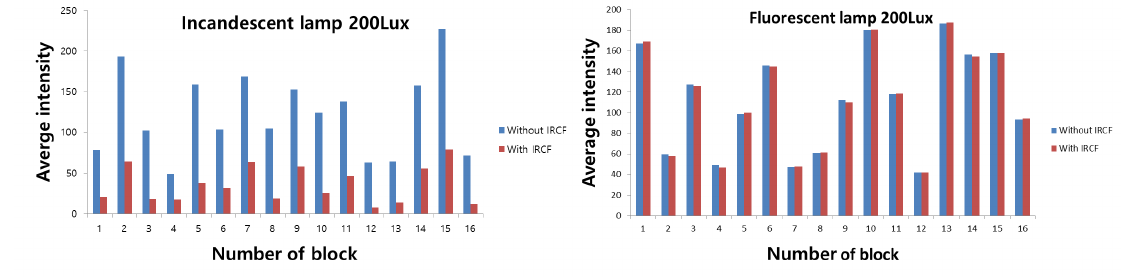
Figure 23. Sensitivity boosting provided by the NIR information. Table 5. Average intensity value with or without IRCF in various